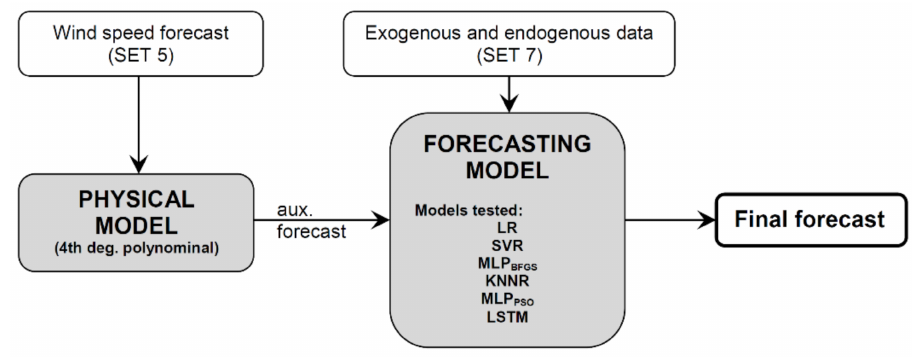
Figure 9. Diagram of series information processing in hybrid method.